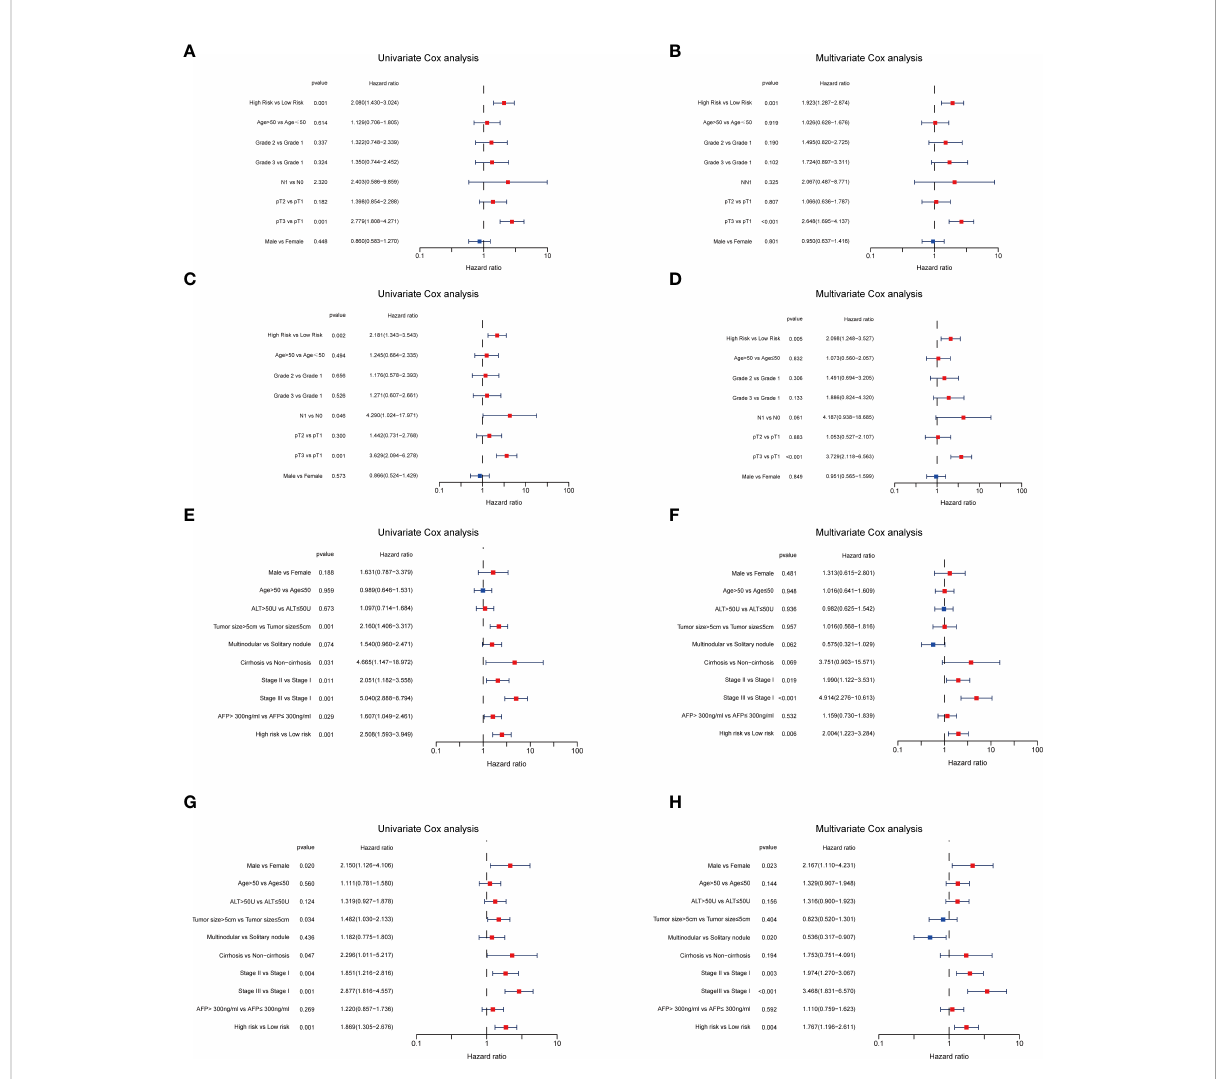
FIGURE 7 Independent prognosis analyses of TRGs risk model in TCGA and GES14520 HCC cohorts. (A, B) , Univariate and Multivariate Cox regression of risk score based on OS in TCGA HCC cohort. (C, D) , Univariate and Multivariate Cox regression of risk score based on DSS in TCGA HCC cohort. (E, F) , Univariate and Multivariate Cox regression of risk score based on OS in GSE14520 HCC cohort. (G, H) , Univariate and Multivariate Cox regression of risk score based on RFS in GSE14520 HCC cohort. TRGs, tyrosine metabolism-related genes; HCC, hepatocellular carcinoma; TCGA, The Cancer Genome Atlas; OS, overall survival; DSS, disease-speci fi c survival; RFS, relapse-free